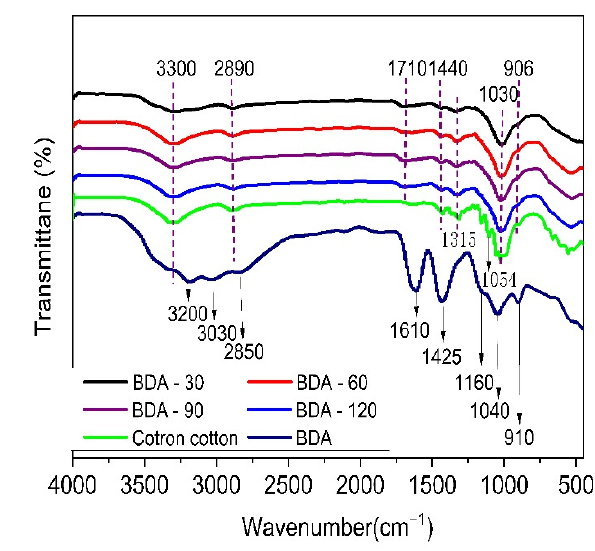
Figure 3. FTIR spectra of BDA, control sample, and BDA ‐ treated samples (3 curing times, 50 LCs).